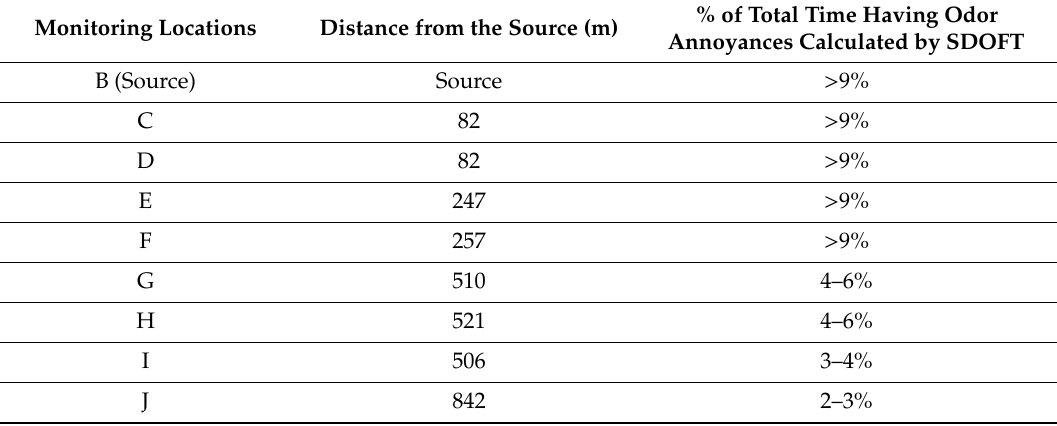
Table 3. Odor annoyance calculated by SDOFT for case study 2.